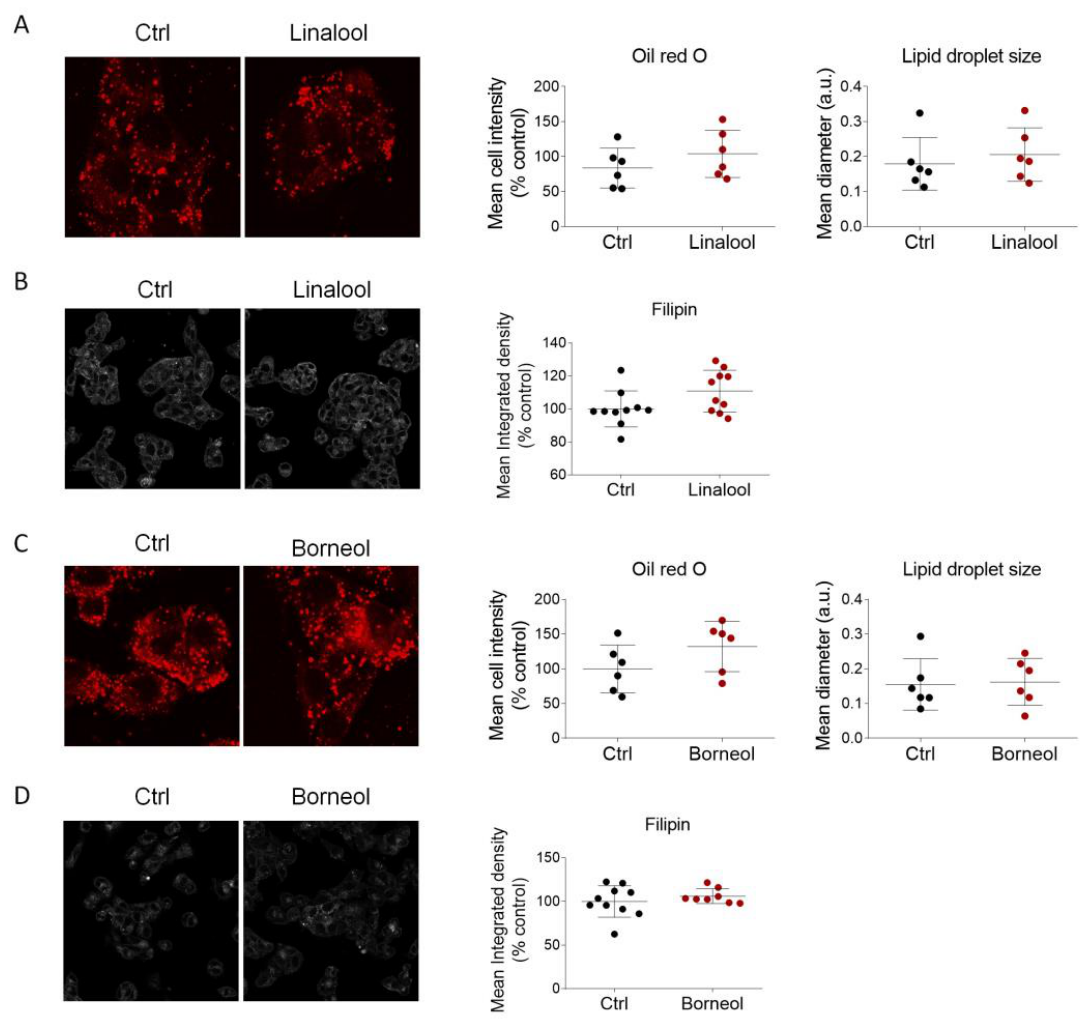
Figure 8. Linalool and borneol do not modulate the content of neutral lipids and cholesterol in HepG2 cells. ( A ) Representative images (left panel) and respective densitometric analysis (right panels) of Oil Red O staining in HepG2 cells treated with the vehicle (DMSO, Ctrl cells) and linalool (0.0018%) for 24 h. n = 6 different biological replicates. ( B ) Filipin staining and its respective fluorescence intensity in HepG2 cells treated as in ( A ). n = 10 different experiments. ( C ) Representative images (left panel) and respective densitometric analysis (right panels) of Oil Red O staining in HepG2 cells treated with the vehicle (Ctrl) and borneol (0.00097%) for 24 h. n = 6 different biological replicates. ( D ) Filipin staining and its respective fluorescence intensity in HepG2 cells treated as in ( C ). n = 10 different experiments. Data represent mean ± SD and the unpaired Student’s t test was used for the statistical analysis.